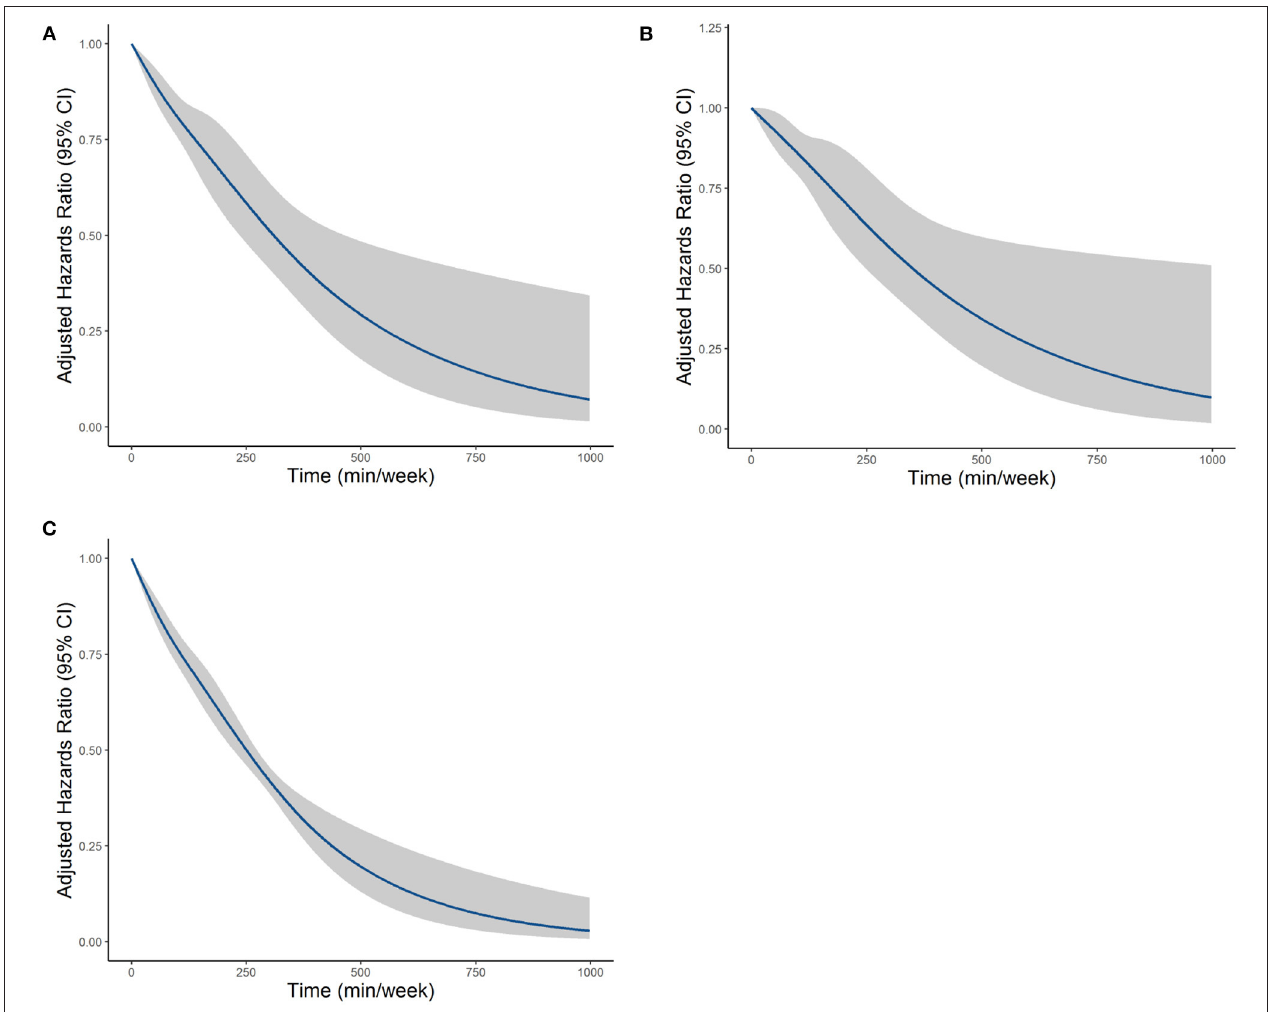
FIGURE 2 | The dose–response relationships between LTPA with (A) CVD, (B) CHD, and (C) CBD, which were estimated by the MSM-Cox with restricted cubic splines. CVD, cardiovascular disease; CHD, coronary heart diseases; CBD, cerebrovascular diseases; LTPA, leisure time physical activity.